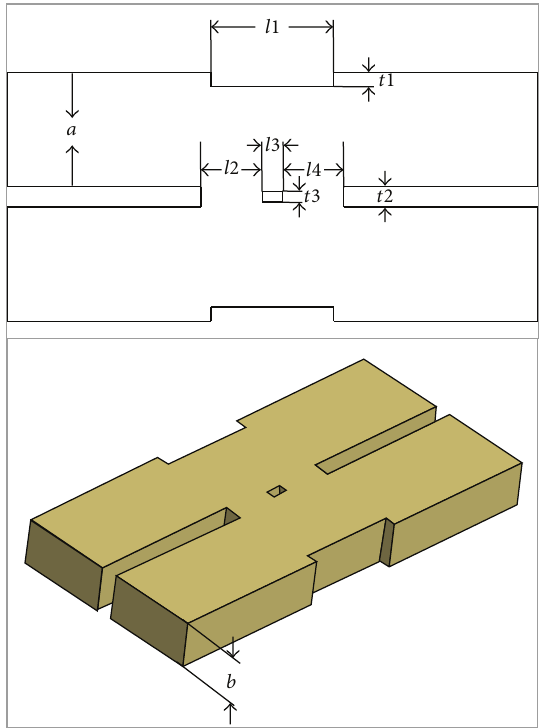
Figure 1: Schematic of the basic structure in the coupler.